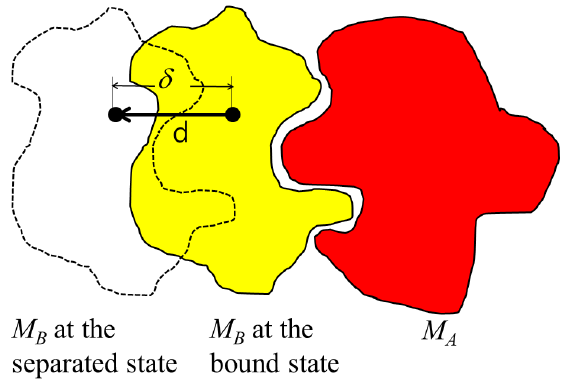
Figure 1. Binding direction versus separating